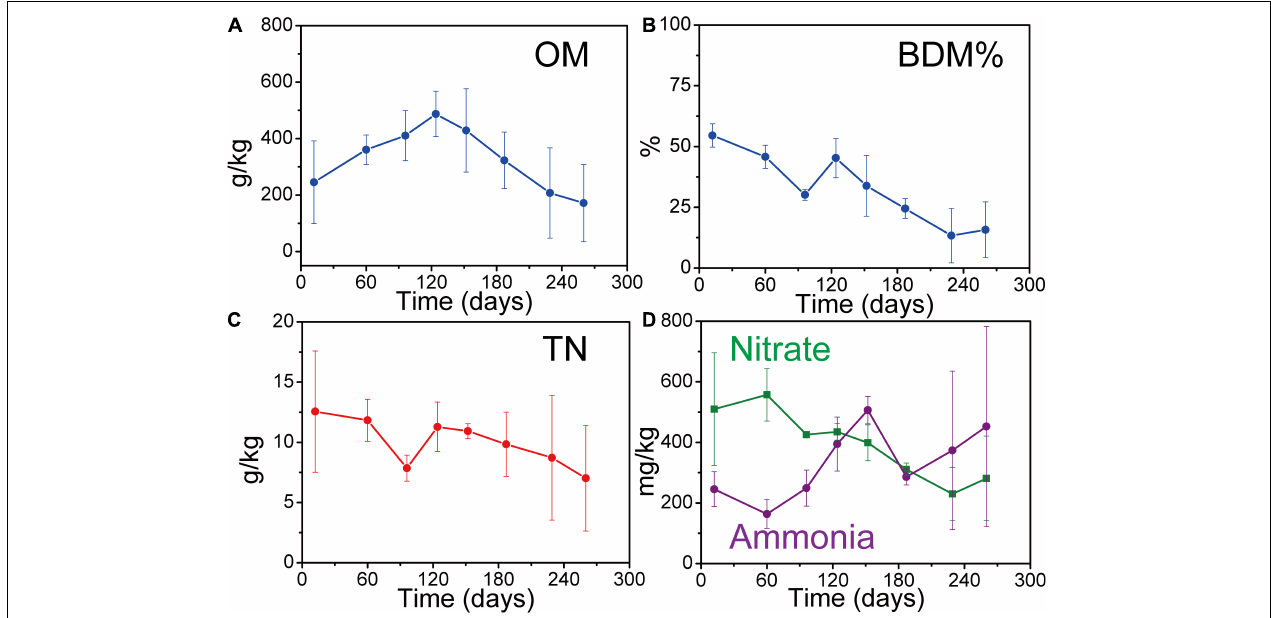
FIGURE 1 | Changes in solid waste key physiochemical parameters during solid waste decomposition. (A) Organic matter (OM) of solid waste. (B) Percentage of biodegradable matter (BDM %) of solid waste. (C) Total nitrogen (TN) of solid waste. (D) Nitrate and ammonia of solid waste. Each sample was determined in triplicate ( n = 3). Error bar is the standard deviation of triplicate